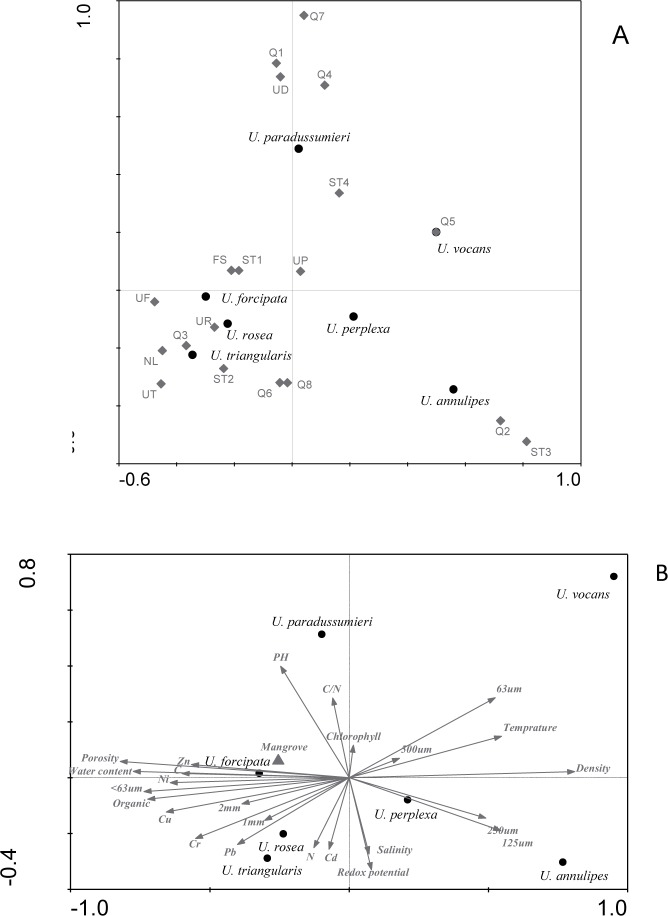
CCA results including biplot of species versus station (a) and species versus environmental parameters (b).Circle (●) and diamond (◊) symbols indicate the position of sampling stations and species respectively, while environmental factors are represented by triangle (Δ) and arrows.